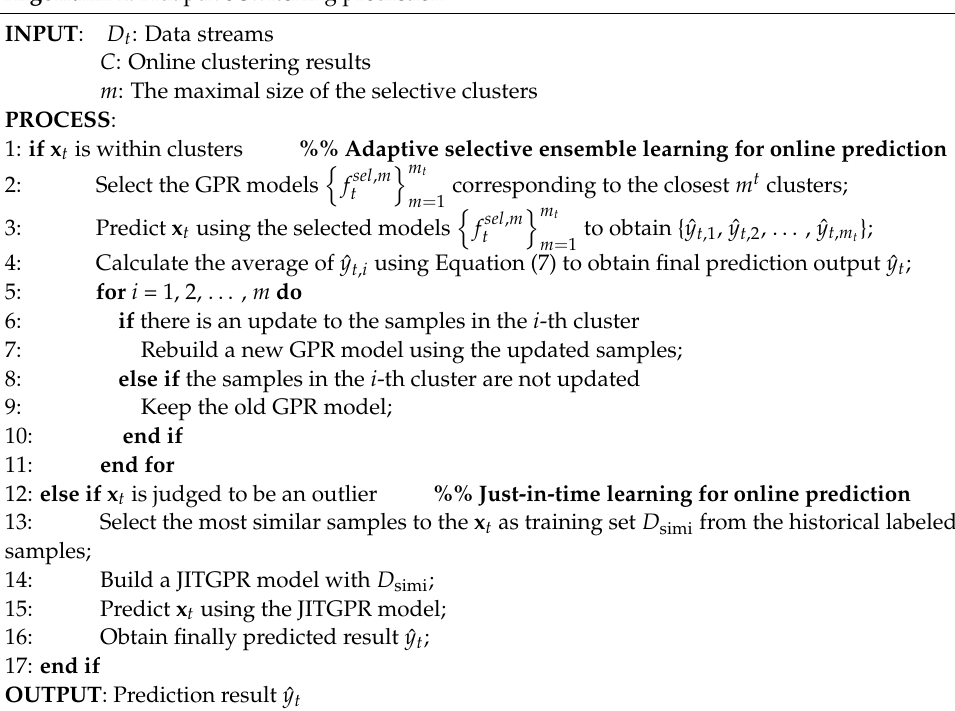
Algorithm 2: Adaptive switching